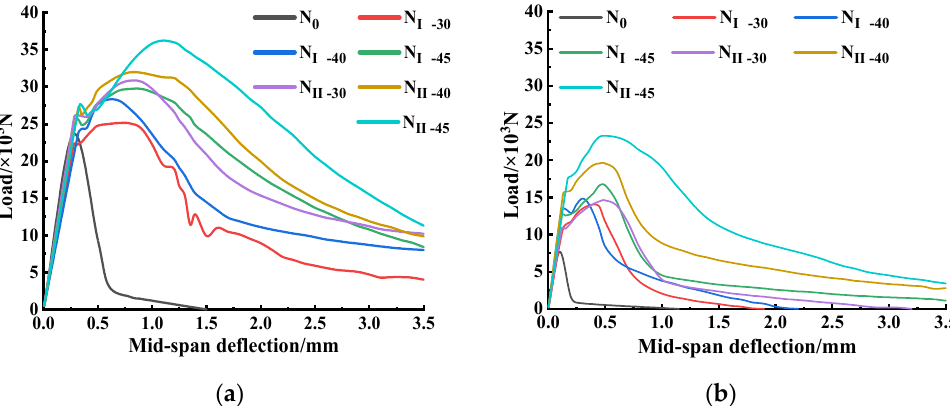
Figure 10. Load-deflection curve before and post-fire: ( a ) normal temperature conditions; ( b ) after-fire conditions.